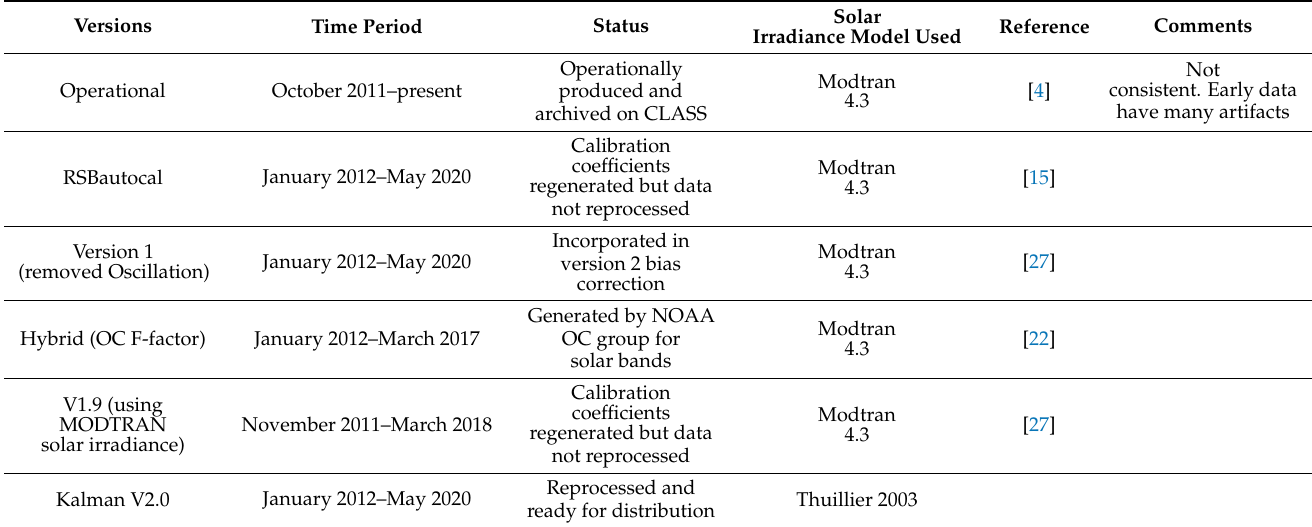
Table 1. Calibration Algorithms used in the Production of Visible Infrared Imaging Radiometry Suite (VIIRS) Sensor Data